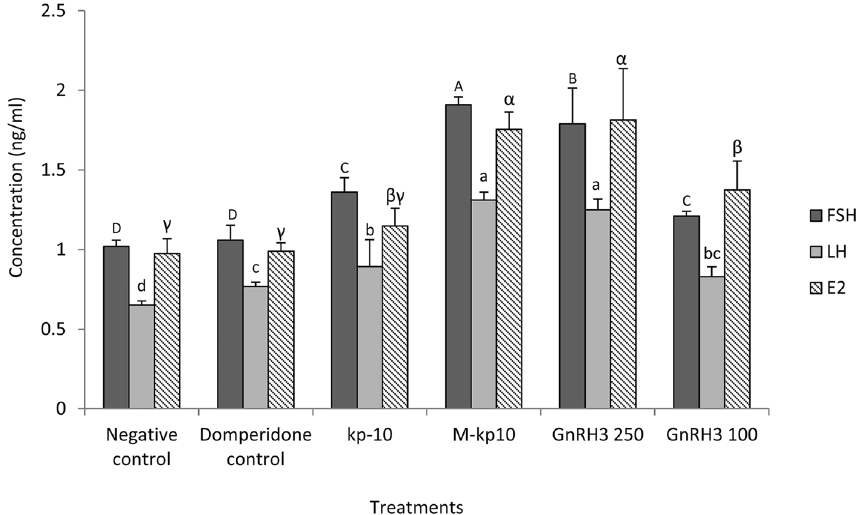
Figure 1. Variations of the luteinizing hormone (LH), the follicle stimulating hormone (FSH) and the 17β estradiol (E2) in the female goldfish treated with kp-10, M-kp10 and GnRH3, 6 h post-injection. The different letters above columns are showing significant differences based on one-way ANOVA and Tukey’s post hoc